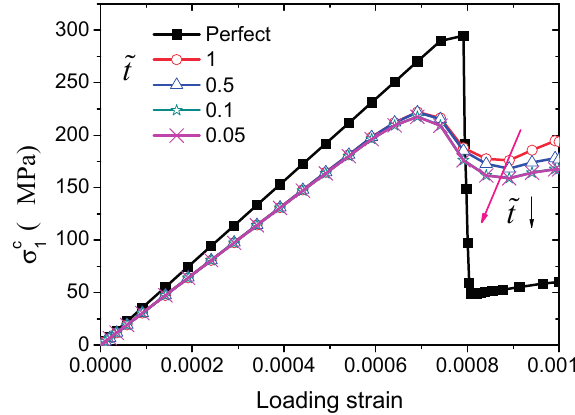
Figure 6. Simulated macroscopic stresses with respect to the loading strain for the C/SiC composites with different interfacial strengths subject to transverse tension along the y 1 direction. Both the black and red arrows represent the descent direction of t 